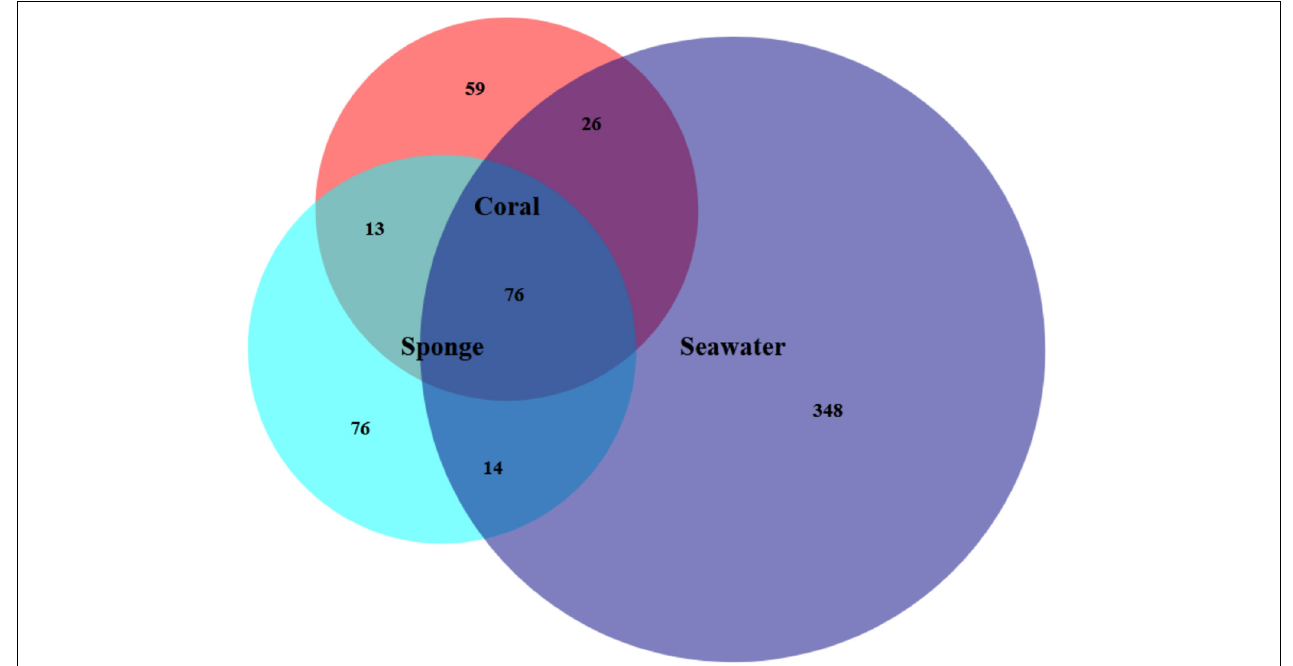
FIGURE 2 | Venn diagram shows the number of Symbiodiniaceae amplicon sequence variants (ASVs) present in each reef habitat compartment (coral, sponge, and seawater), as well as the amount of overlap between and among samples.